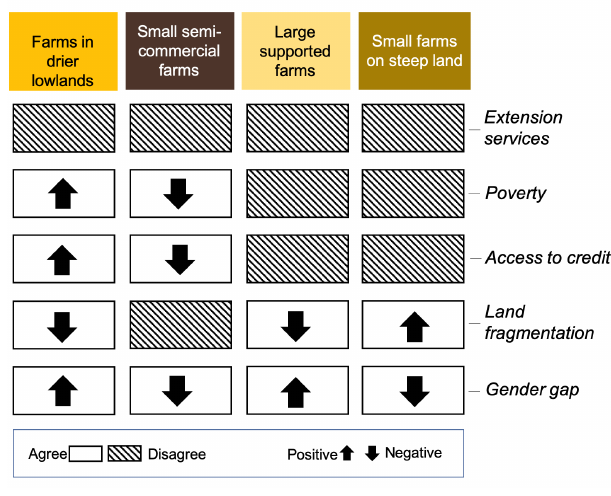
Fig. 7. Match between spatial data and stakeholders’ perceptions. Rectangles show agreement (white) and disagreement (dashed) between district data (averaged at spatial cluster level) and the Priority Score (from stakeholders’ perceptions) within the four spatial archetypes. The two sets of data agree when both exhibit conditions higher (upward arrow) or lower (downward arrow) than the national average, otherwise they disagree. The five spatial attributes are the common ones between spatial and cognitive